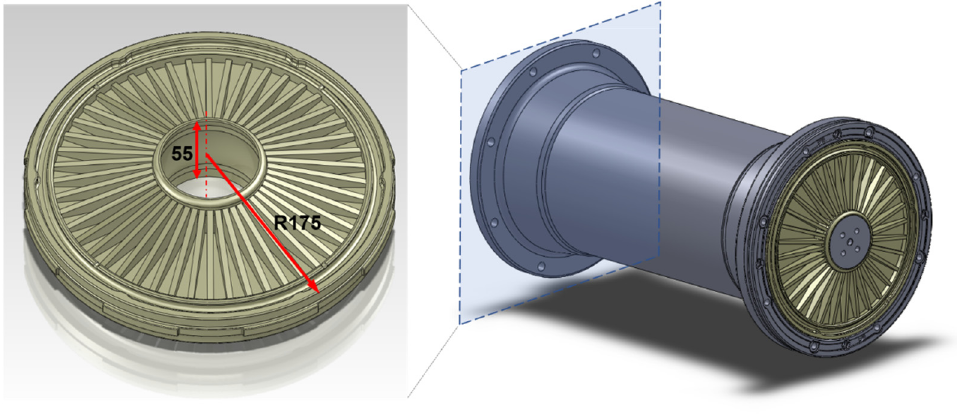
Figure 1. Schematic models of a barrier insulator ( left ) used in GIS ducts ( right ). During normal operation, disk insulators are subjected to mechanical loading—they support the weight of the conductive bars and transfer electromagnetic forces to the enclosure. Additionally, during maintenance of particular GIS sections, insulators are bent due to gas pressure acting only on one side of the disk. From a dielectric viewpoint—the object is exposed to a strong electric field, which is manifested by partial discharges arising from defects in the material, such as voids or pores. The evaluation of the electrical response of the tested disks was a subject of previous tests, including the electrical breakdown strength. The tests showed that, depending on the applied voltage and the type of insulation gas, the critical size of defects causing dielectric problems ranges from 0.2 to 0.7 mm. The setups of these tests are presented in Figure 2.